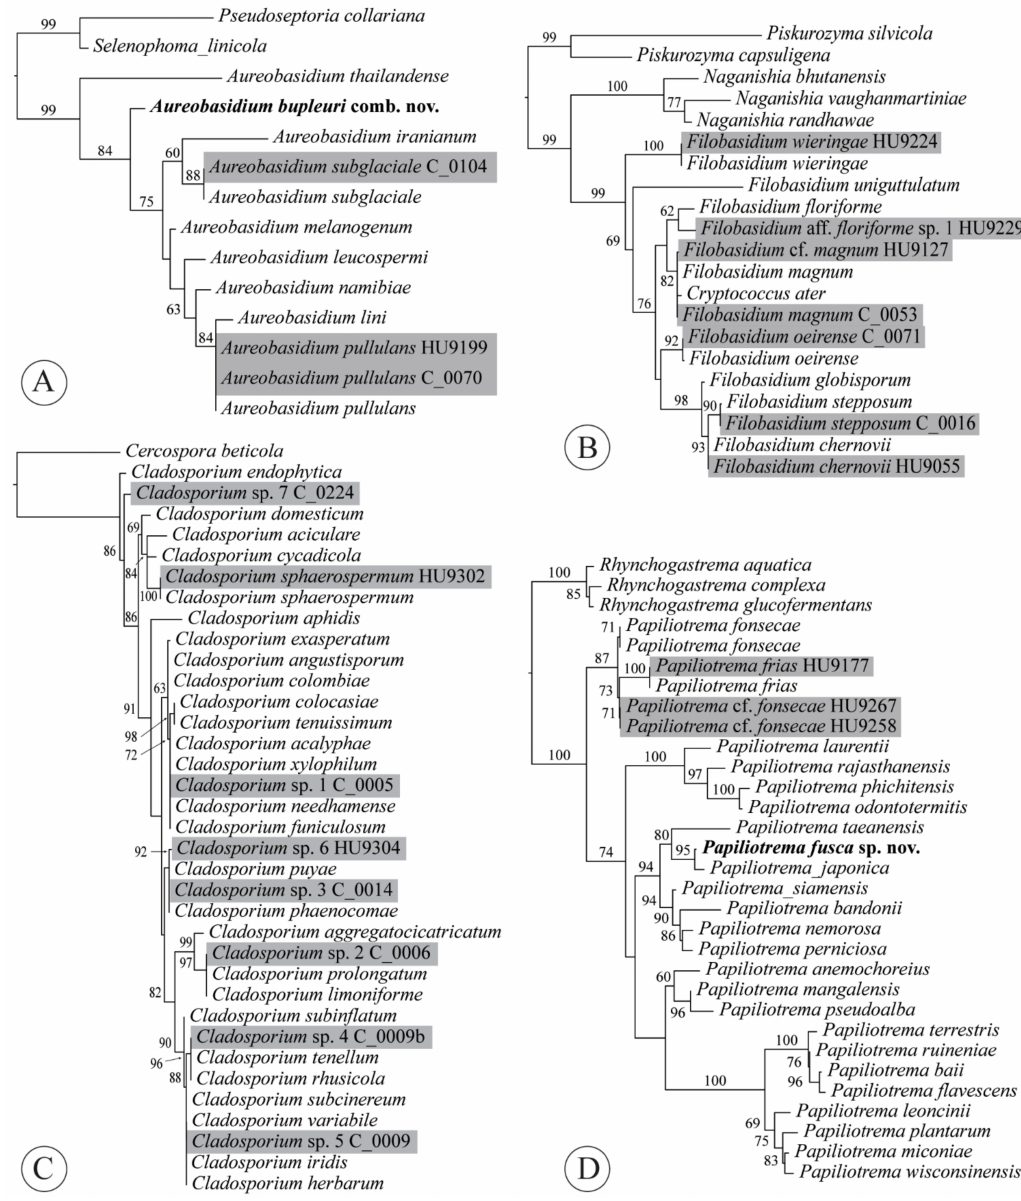
Figure 4. Phylogenetic reconstructions based on ITS sequences for the following genera: ( A ), Aureobasidium ; ( B ), Filobasidium ; ( C ), Cladosporium ; and ( D ), Papiliotrema . Topologies are the result of ML inference performed with IQ-TREE. For each node, the ML bootstrap (if ≥ 60) is presented above/below the branch leading to that node. Gray shading added for strains obtained from romaine lettuce samples during this